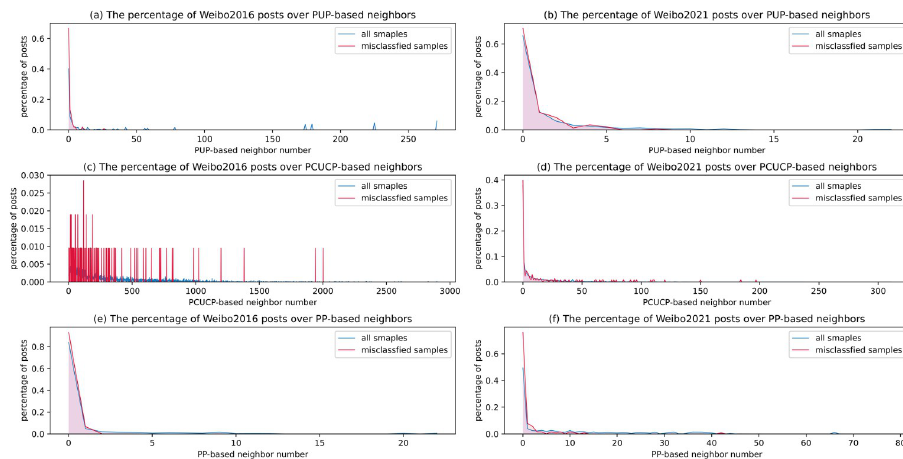
Fig 4. The percentage of posts over the number of 3 types of meta-path-based neighbors. The left column depicts how the proportion of posts changes in the Weibo2016 dataset, while the right column depicts that of the Weibo2021 dataset. The red line represents misclassified samples, and the blue line represents all